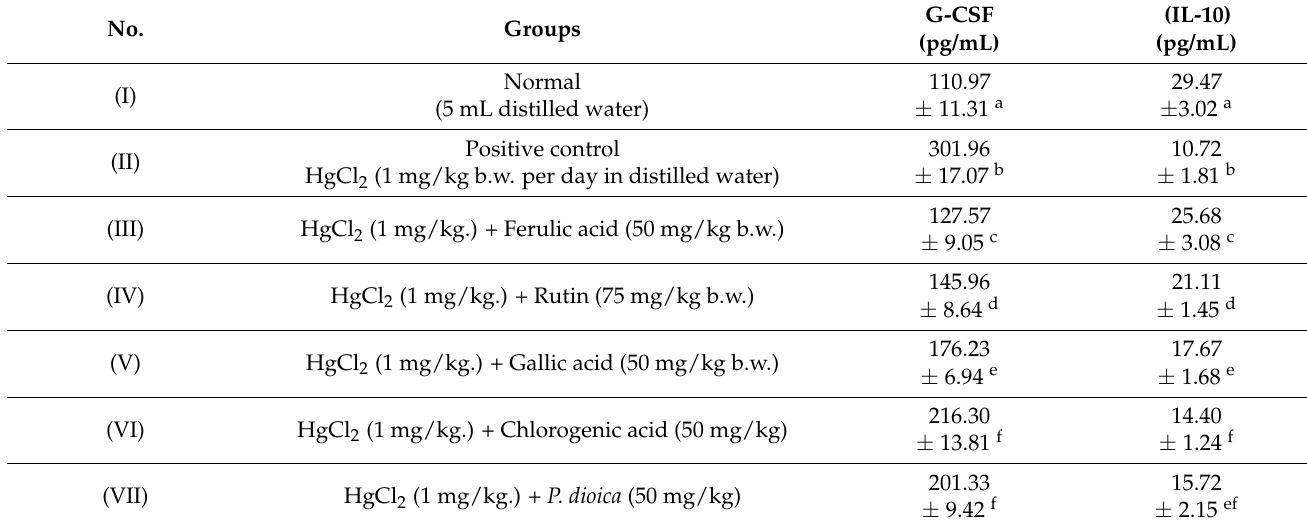
Values represent the mean ± SE ( n = 10). Data shown are mean ± standard deviation of the number of observations within each treatment. Data followed by the same letter (a, b, c, d, e, and f) within the same parameter are not significantly different at p ≤ 0.05.